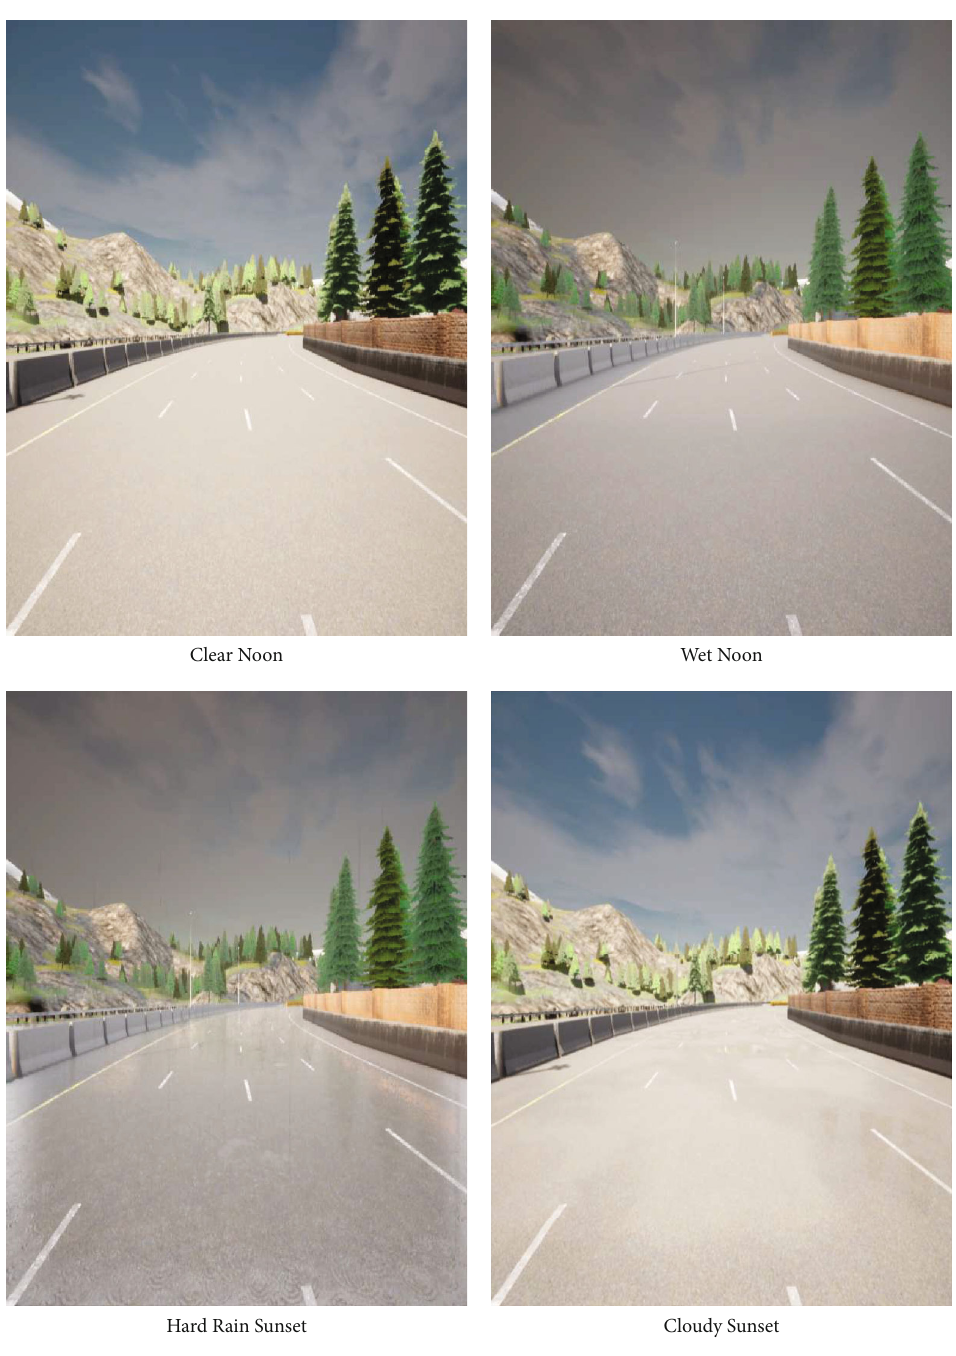
Figure 5: Same road under 4 di ff erent weather